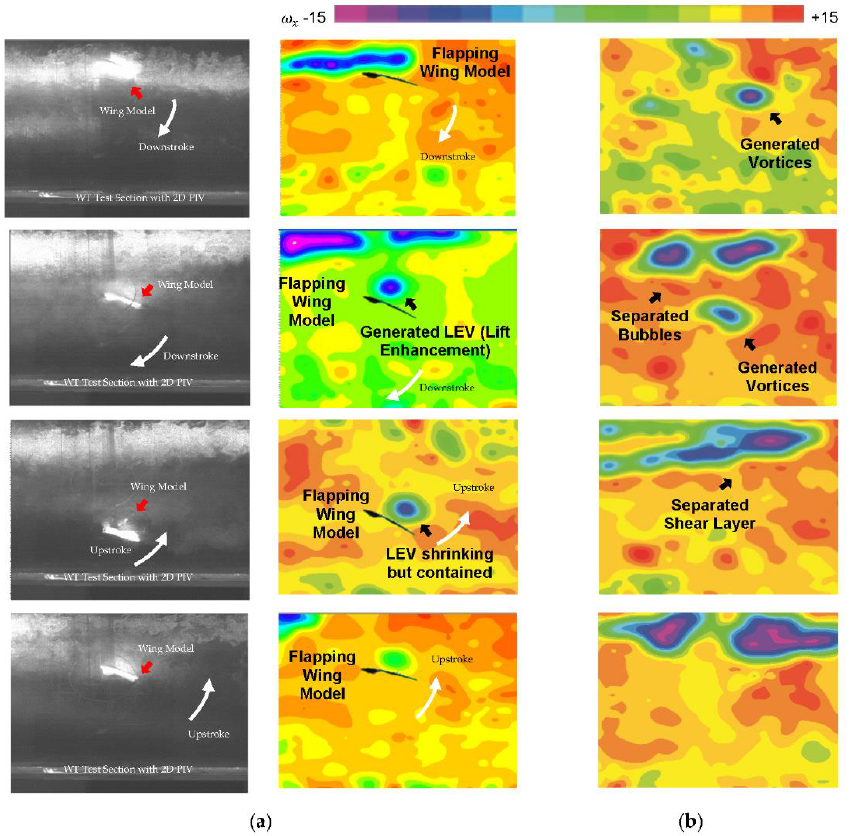
Figure 10. ( a ) One sample of the motion of the wing model along the stroke plane in the wind